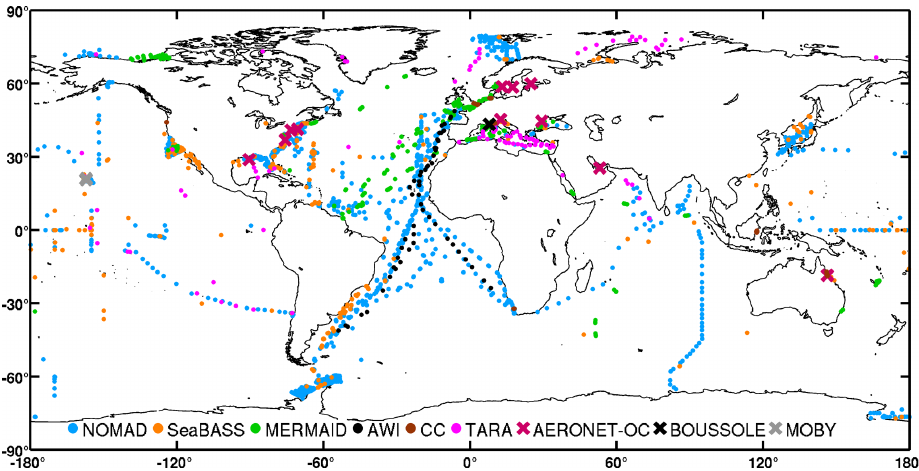
Figure 5. Global distribution of remote-sensing reflectance per dataset in the final table. The data sources are identified with different colours. Points show locations where at least one observation is available. Crosses show sites from which time series data of remote-sensing reflectance are available.